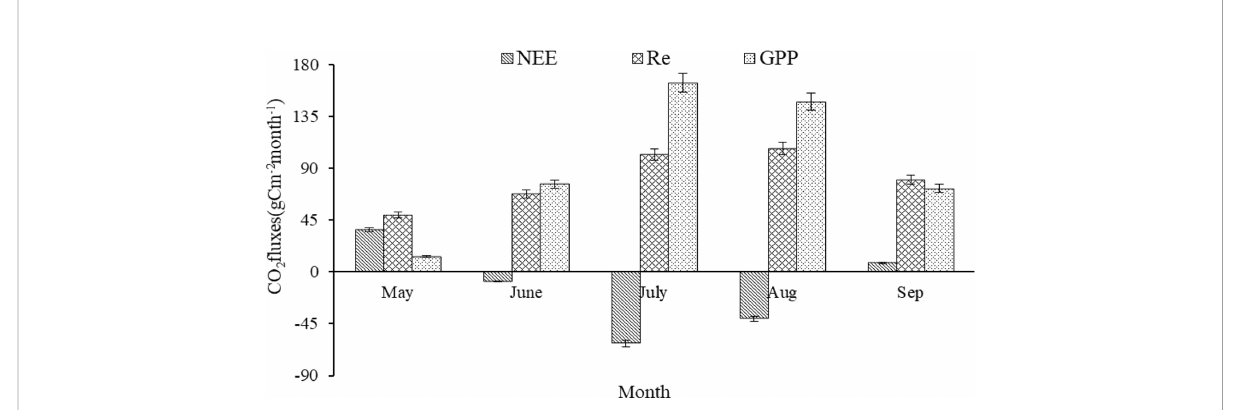
FIGURE 2 The average value of monthly CO 2 fl uxes (gCm -2 month -1 ) of alpine wetland in the growing season for the period